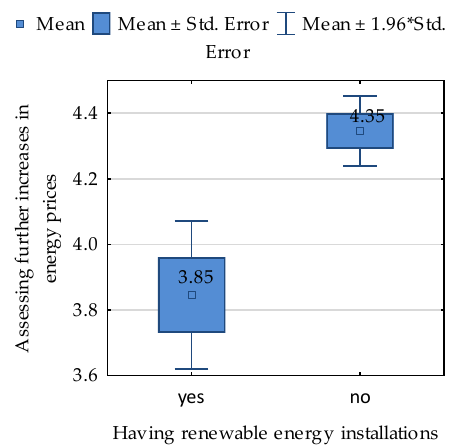
Figure 6. Having renewable energy installations vs. assessing further increases in energy prices. Source: own